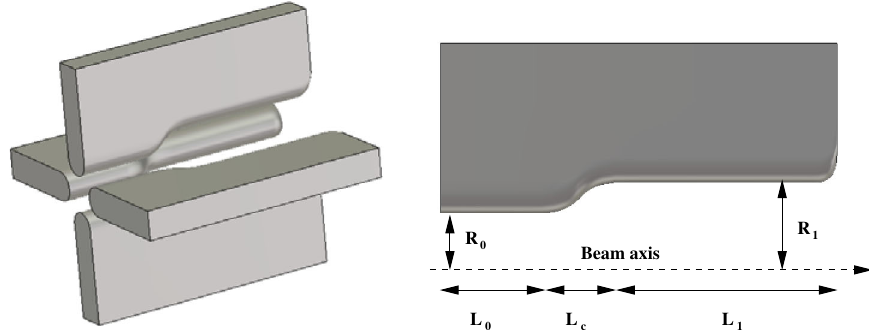
FIG. 5. Geometry of the new type of output radial matcher: A 3D view (left) and a 2D profile showing the parameters of the geometry (right).